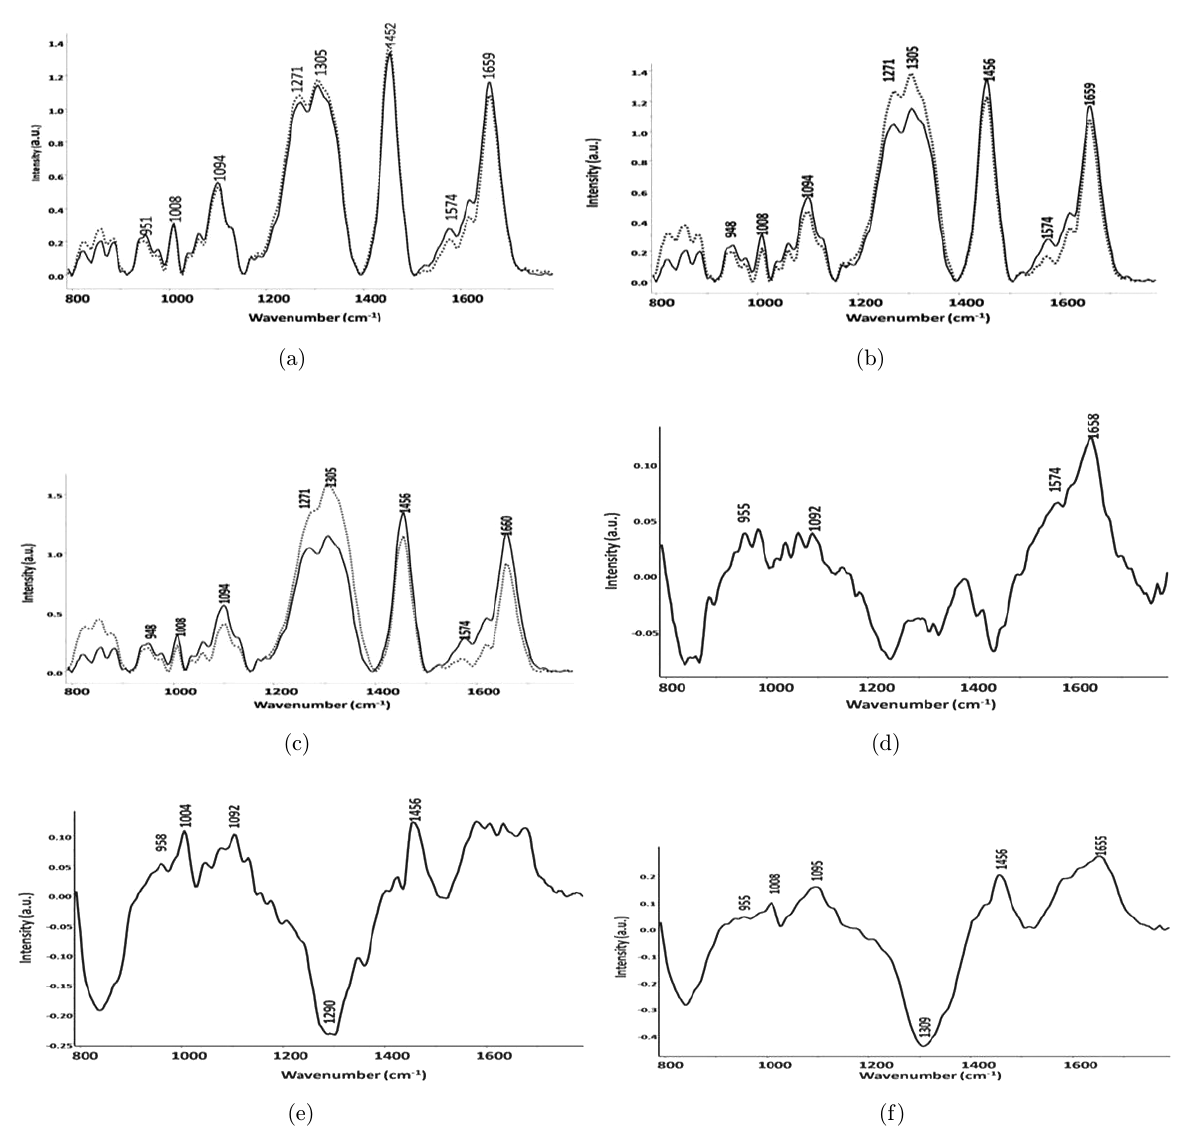
Fig. 4. Mean spectra of MDA-MB-231 cells: control (solid line), PTX treated (broken line) (a)-1 mM, (b)-2.5 mM, (c)-5 mM. Comparison of di®erence spectra across control and treatment groups (d): Control – 1 mM PTX treatment, (e): Control – 2.5 mM PTX treatment and (f): Control — 5 mM PTX treatment.